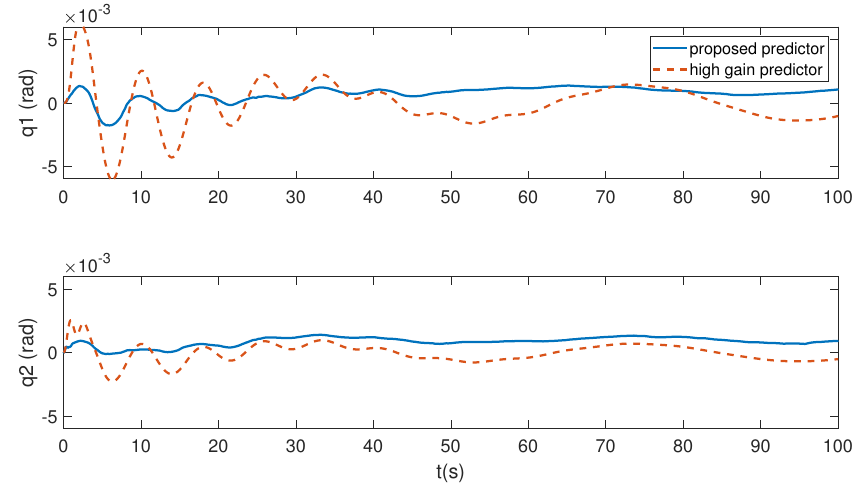
Figure 9. Compared results of position prediction errors.